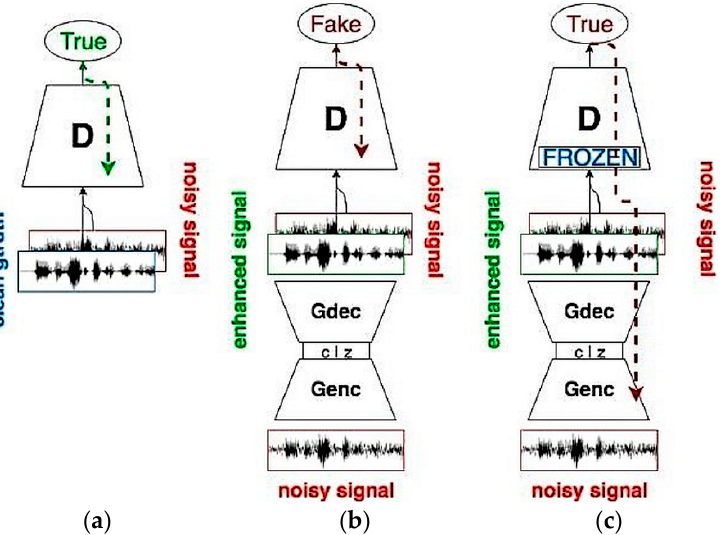
Figure 21. Waveform and spectrogram of: ( a ) clean; ( b ) noisy; and ( c ) enhanced speech correspond- ing to the sentence—“We were surprised to